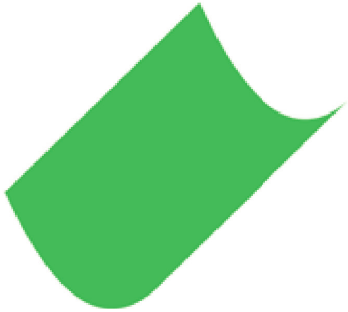
Figure 2: Explicit surface 1.